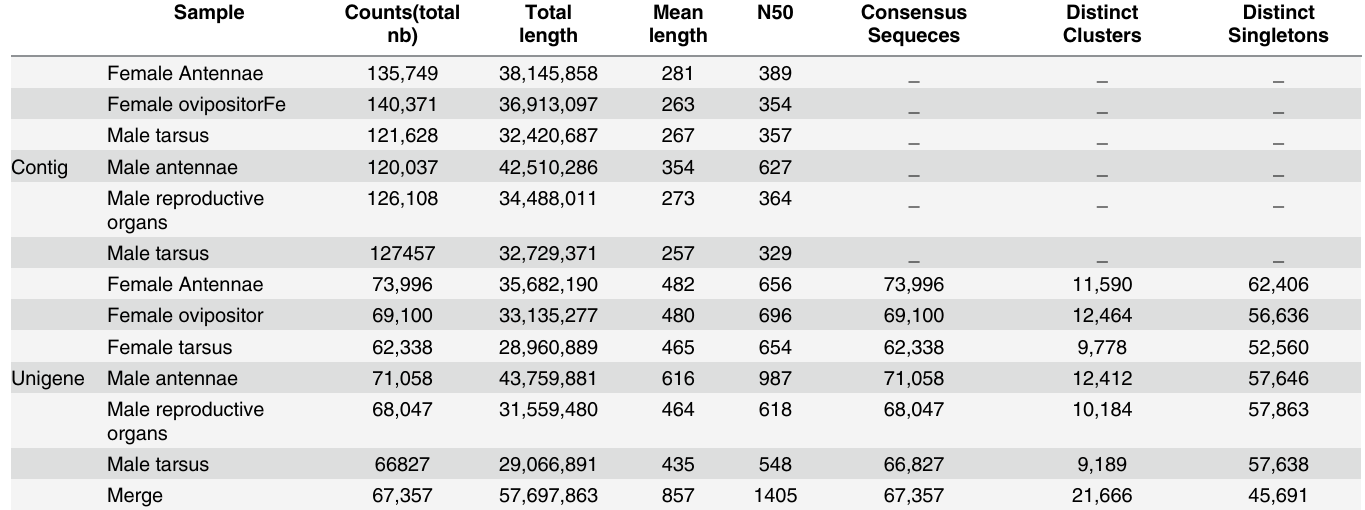
Table 1. Data summary.